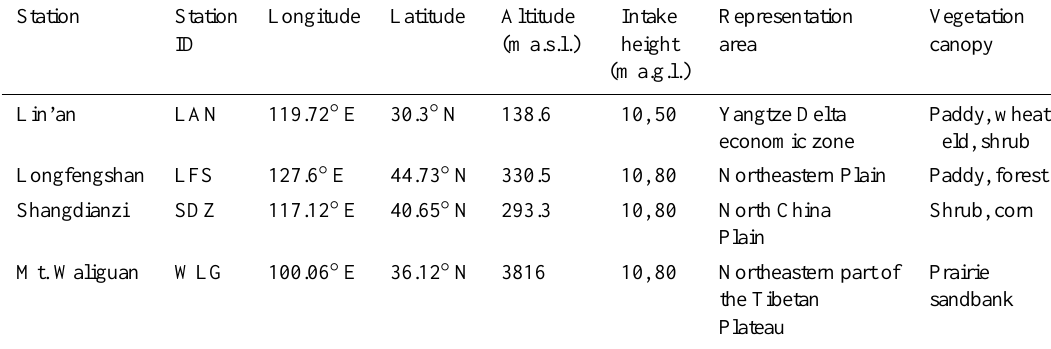
Table 1. Descriptions of the four WMO/GAW stations in China. Station Station Longitude Latitude Altitude Intake Representation Vegetation ID (ma.s.l.) height area canopy (ma.g.l.) Lin’an LAN 119.72 ◦ E 30.3 ◦ N 138.6 10, 50 Yangtze Delta Paddy, wheat economic zone field, shrub Longfengshan LFS Northeastern Plain Paddy, forest Shangdianzi Mt.